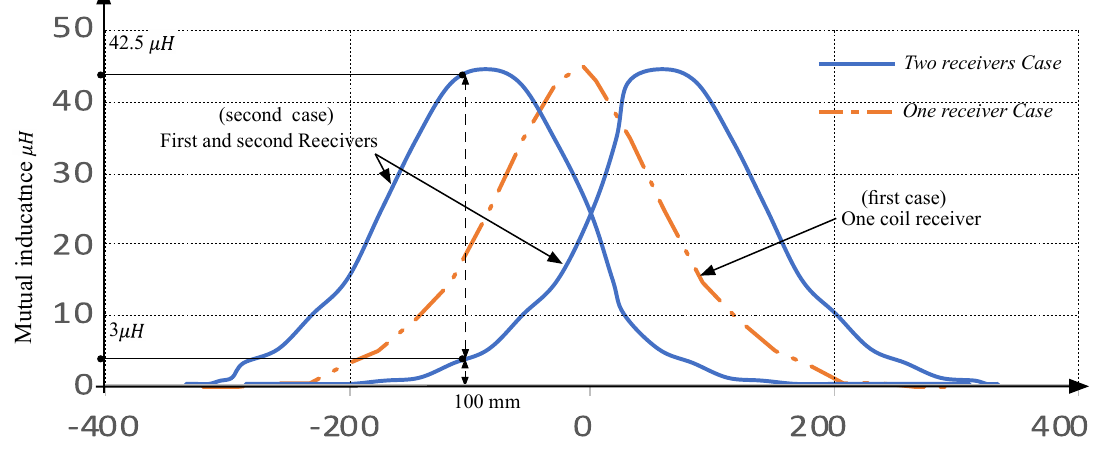
Figure 13. Mutual inductance with one and two receivers.